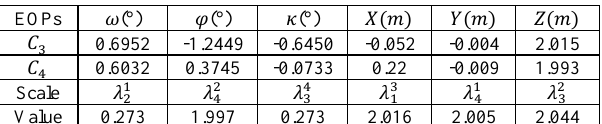
Table 3. Solved EOPs in the experiment.